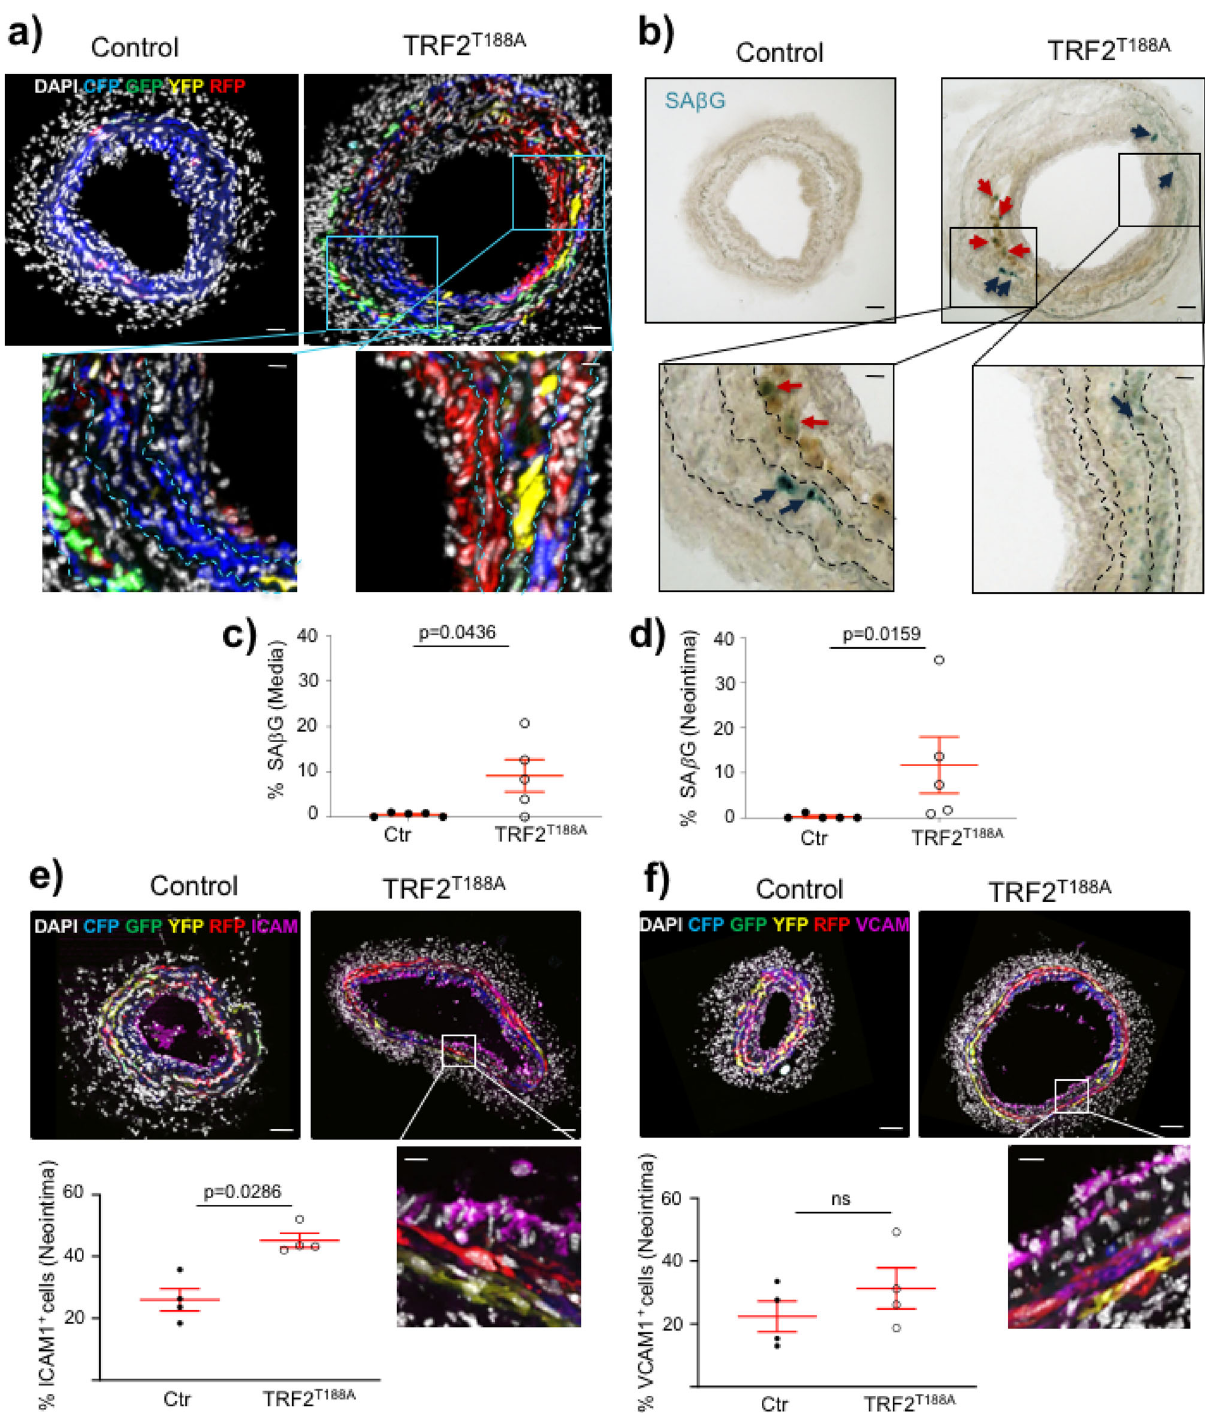
Fig. 8 TRF2 T188A promotes senescence and expression of adhesion molecules in the neointima. a Cryosections of LCCAs, 28d post ligation in control and TRF2 T188A mice detected for confetti + cells and DAPI (white). Scale bar = 30 μ m and 13 μ m (inset). b Cytochemical staining of the same section with chromogenic SA β G. Outlined regions show magni fi ed SA β G + cells in the media (indicated by blue arrows) or neointima (indicated by red arrows). Scale bar = 30 μ m and 9.5 μ m (inset). Dashed lines indicate elastic laminae. Quanti fi cation of SA β G + cells in c media and d neointima, expressed as a percentage of SA β G + cells over DAPI. e , f Immunohistochemistry for ICAM-1 (left) and VCAM-1 (right) (magenta) of LCCAs, 28d post ligation in control and TRF2 T188A mice, also detected for confetti + cells. Scale bar = 80 μ m and 16 μ m (inset). Quanti fi cation of ICAM-1 + or VCAM-1 + cells in neointima expressed as a percentage of ICAM-1 + or VCAM + cells over DAPI. Data represent means±SEM, n = 4 – 5 mice per group, unpaired, two-tailed Student ’ s t test or Mann – Whitney U